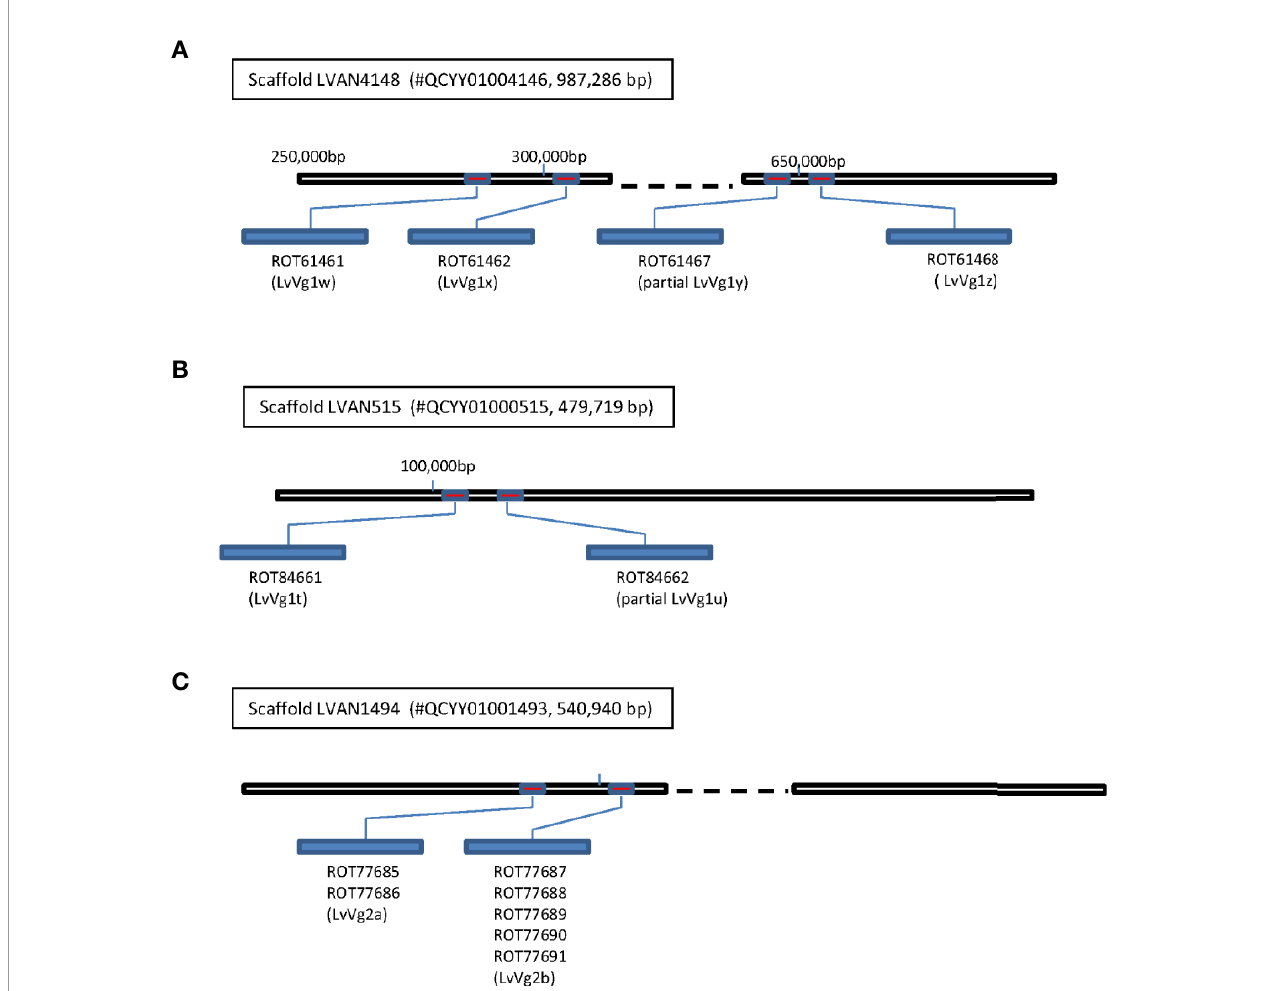
FIGURE 4 | Clustering of vitellogenin/vitellogenin-like genes in the whiteleg shrimp L. vannamei genome. Three Vg gene clusters were identi fi ed from the L. vannamei genome sequencing project reported by Xiang ’ s group (22). The draft genome sequence was retrieved from GenBank database with an accession number PRJNA438564 (https://www.ncbi.nlm.nih.gov/bioproject/PRJNA438564). (A) Four LvVg1 related genes (red boxes) were identi fi ed from Scaffold LVAN4148 (#QCYY010004146); (B) The Scaffold LVAN515 (#QCYY01000515) consisted of another two LvVg1 related genes; (C) The Scaffold LVAN1494 (#QCYY01001493) consisted of a cluster of two LvVg2 genes (red boxes). The deduced Vgs from these genes are shown in the blue elongated bars with GenBank accession numbers shown below the